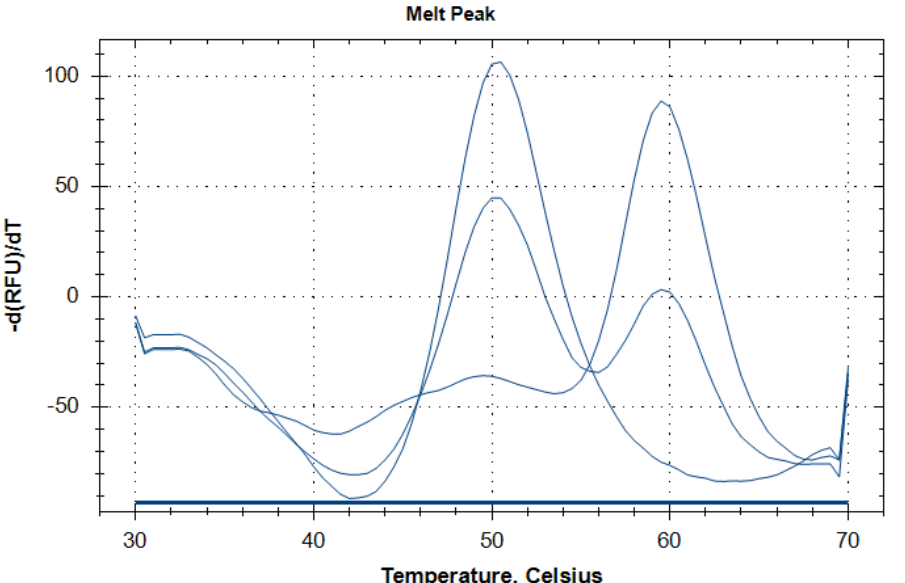
Figure 1. Representative melting curves corresponding to three different genotypes of TRPM8 rs2052030 polymorphism. Single peaks at 60 ◦ C and 50 ◦ C correspond to the CC and GG genotypes, respectively. Simultaneous presence of both peaks indicates the heterozygous CG genotype.